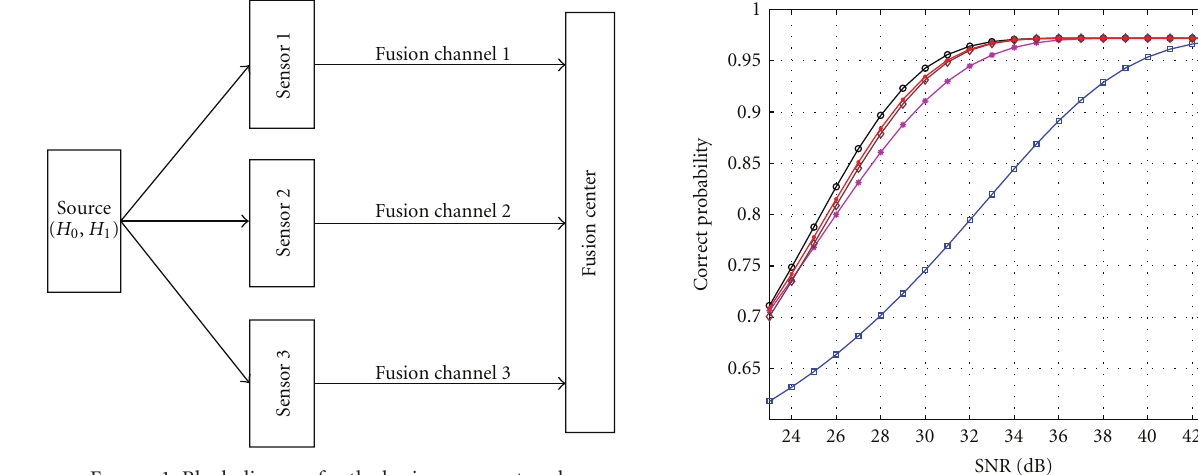
Figure 1: Block diagram for the basic sensor network.